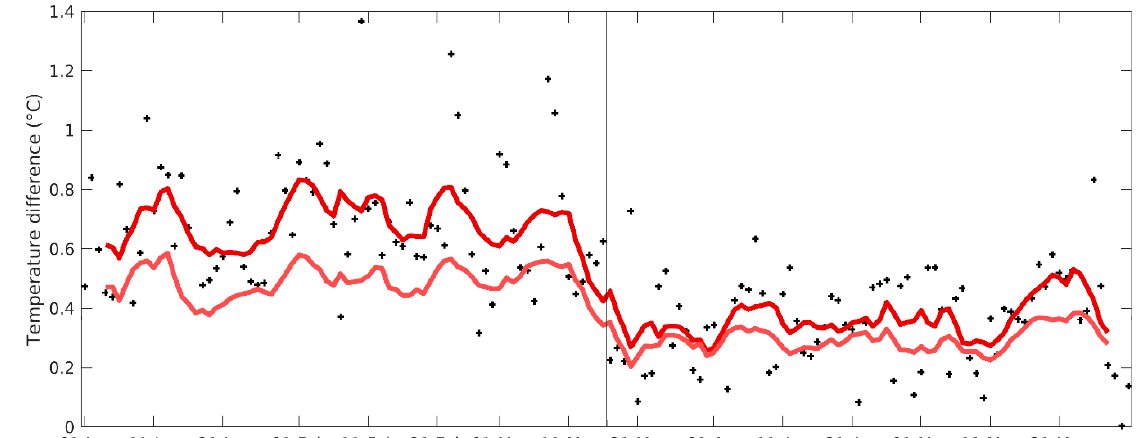
Figure 5. Daily evolution of maximum 2 m temperature differences between grid cells with sensible heat flux from traffic exceeding 25 W m − 2 and adjacent cells for January to May 2020 in the GEM_COVID simulation (black symbols). The 7-day moving average is shown in dark red. The light red line shows the 7-day moving average for grid cells exceeding 10 W m − 2 .